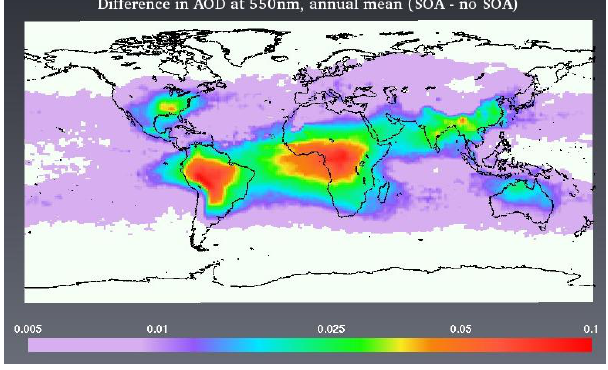
Figure 9. AOD at 550nm with SOA (above, left), without SOA (above, right) and the difference (below).